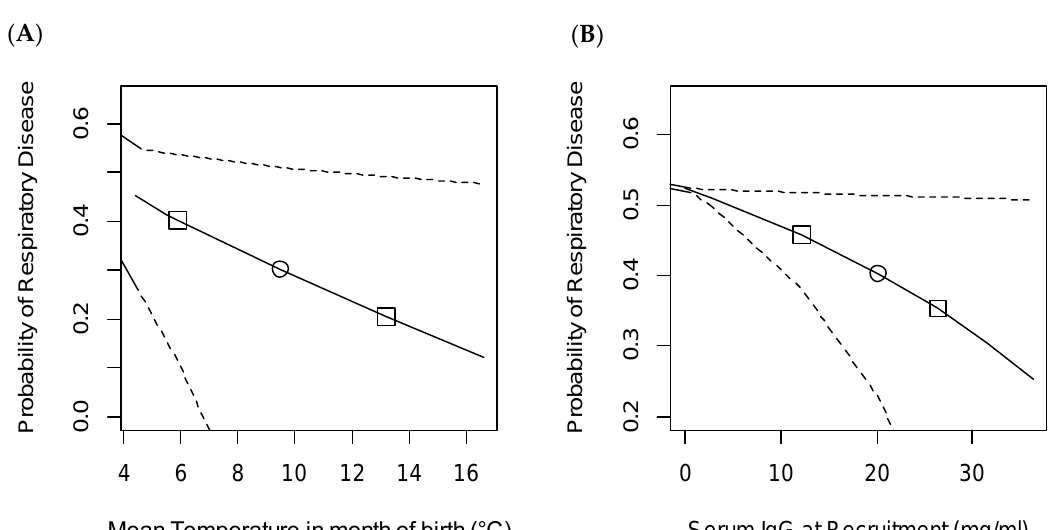
Figure 3. Predicted probability of bovine respiratory disease (BRD) preweaning based on variation in ( A ) mean temperature in the month of birth and ( B ) IgG at recruitment (mg/mL). The marginal mean probability of respiratory disease was calculated for the observed range of the variables with all other covariates held constant at their median value. The study included 492 heifers recruited from 11 farms. Dashed lines show 95% confidence intervals, ○ median value, □ 25th and 75th centile.